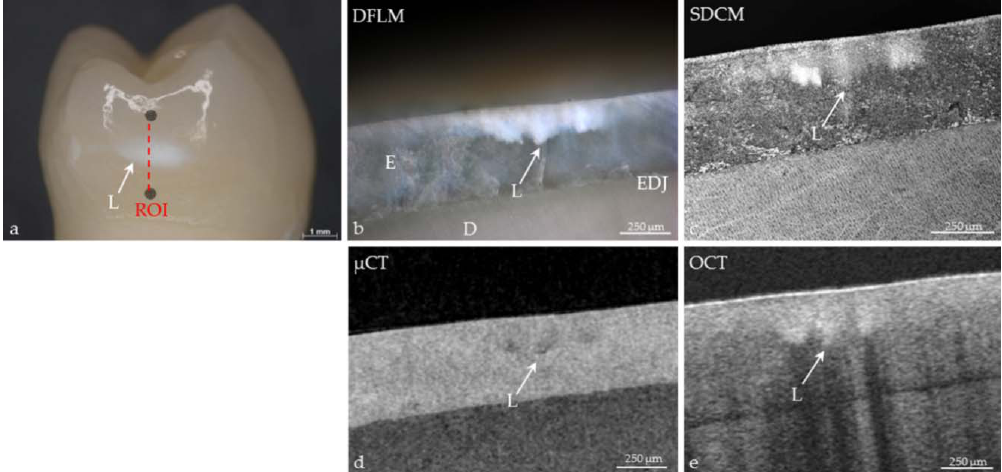
Figure 6. Extracted human premolar with a carious lesion (L) of ICDAS II Code 1. ( a ) ROI; ( b ) The demineralization within the ROI (white arrow) is equally imaged by dark-field light microscopy (DFLM); ( c ) spinning-disc confocal microscopy (SDCM); ( d ) X-ray microtomography ( µ CT); as well as ( e ) SD-OCT. E: enamel, D: dentin, EDJ: enamel-dentin-junction.